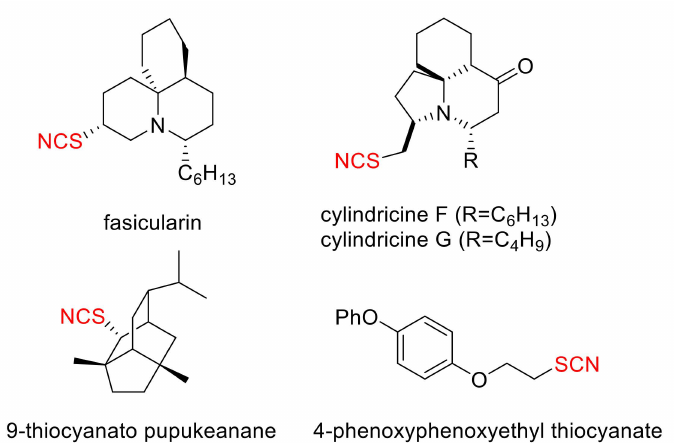
Figure 2. Selected biologically active molecules containing thiocyano